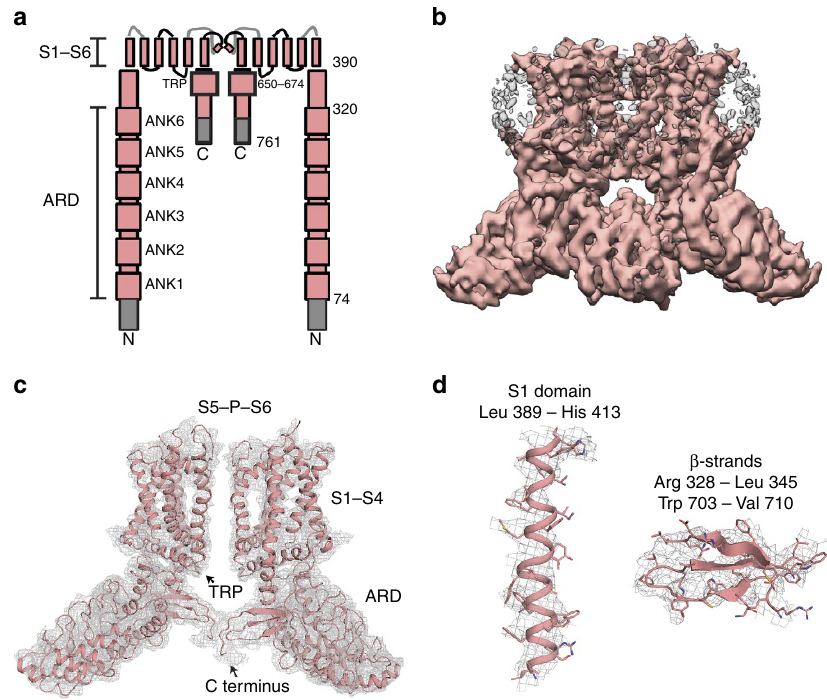
Figure 1 | Single particle cryo-EM analysis of full-length TRPV2. ( a ) Schematic depiction of full-length rat TRPV2 shown as a dimer with its ankyrin repeat domain (ARD), S1–S4 helices, S5–P–S6 pore domain and C terminus. Missing densities in the corresponding full-length TRPV2 cryo-EM map are depicted in grey. ( b ) Final full-length TRPV2 cryo-EM map. ( c ) The TRPV2 atomic model is superimposed onto two subunits of the tetrameric full-length TRPV2 cryo-EM map. ( d ) Superimposition of representative regions of the full-length TRPV2 cryo-EM map (mesh) with the atomic model (ribbons and sticks), including a helix and b